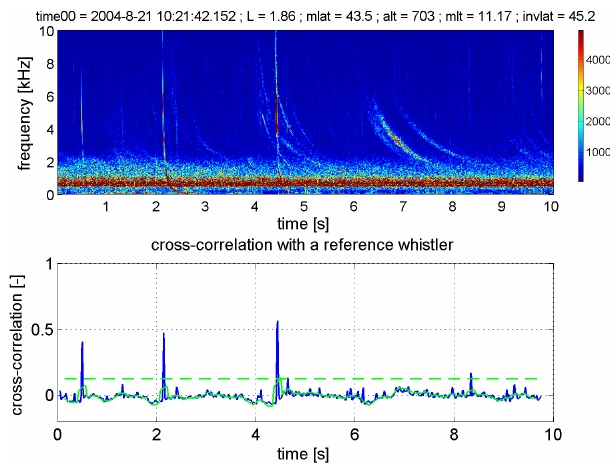
Fig. 2. Top: An example of the spectrogram computed from the ICE burst mode data. Bottom: The cross-correlation function (blue line) of the spectrogram with the reference whistler, 13-point run- ning average of the cross-correlation function (solid green line) and 0.125 detection threshold (dashed green line). See the text for more